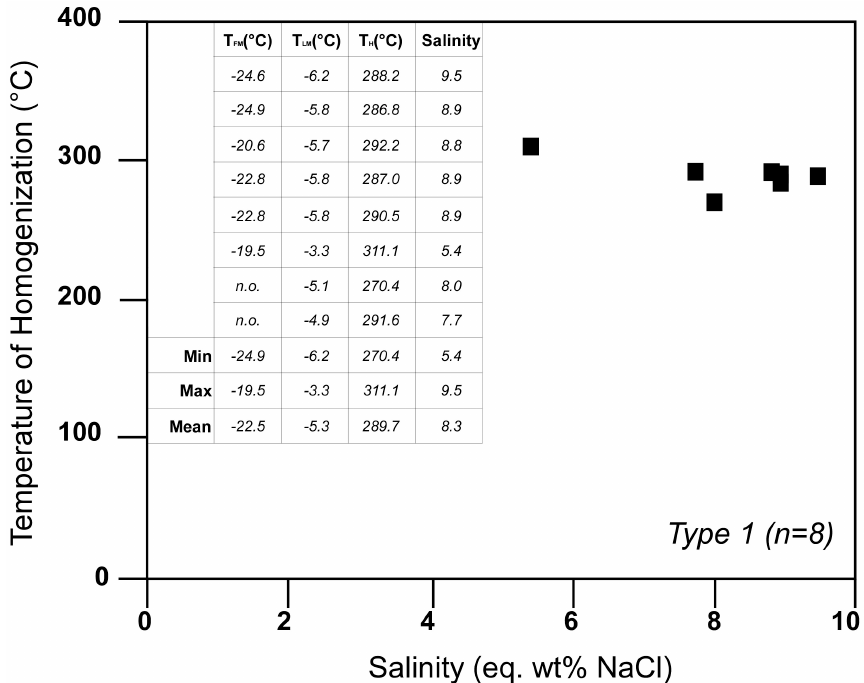
Figure 5. T H –salinity bivariate plot for Type 1 aqueous fluid inclusions showing the narrow range of T H (270–310 °C) and salinity (5 to 10 eq. wt % NaCl). On the left is a table of microthermometric data. Temperature of first ice melting (T FM ), temperature of last ice melting (T LM ), temperature of homogenization (T H ) and salinity (eq. wt % NaCl). n.o.: not observed.